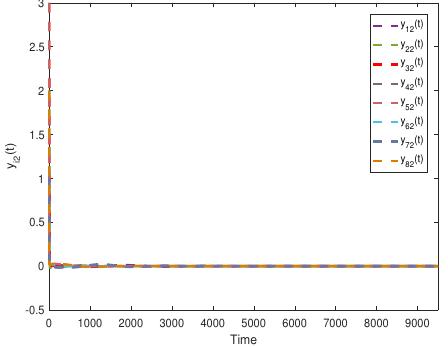
Figure 5. The trajectories of y i 2 ( t ) .